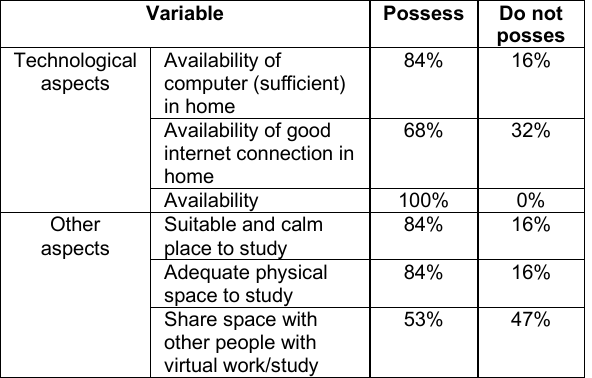
Figure 7. Survey of students about the virtual